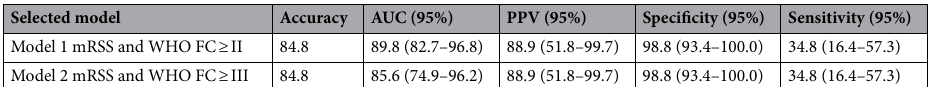
Table 4. Generalizability of selected model(s) presented as accuracy, area under ROC, positive predictive value, specificity, and sensitivity. 95% CI 95% confidence interval, AUC Area under the receiver operating characteristics (ROC), mRSS modified Rodnan skin score, WHO FC World Health Organization functional